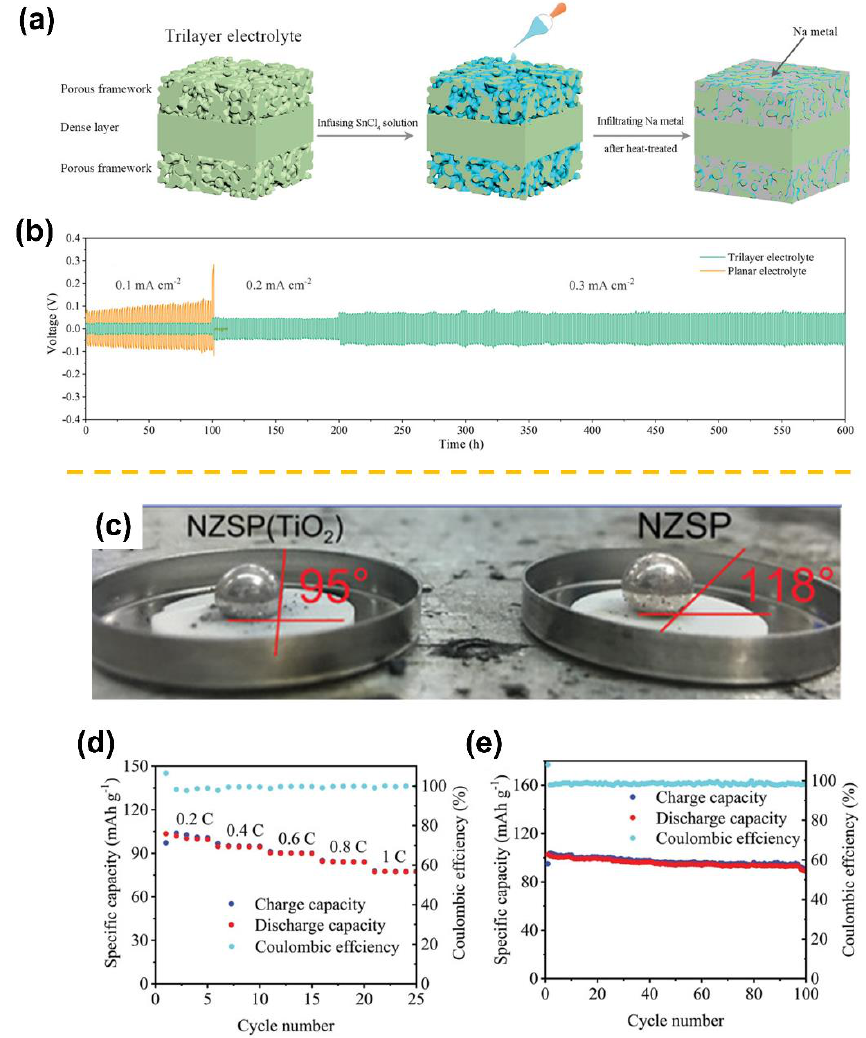
Figure 3. ( a ) Schematic illustration of a trilayer NZSP solid-state electrolyte. ( b ) Voltage profiles of trilayer and planar electrolyte-based symmetric cells. Both electrolytes were surface-modified by SnO 2 (adapted with permission from Wiley). ( c ) Contact-angle measurements for molten Na on NZSP and NZSP (TiO 2 ) surfaces. The Na 3 V 2 (PO 4 ) 3 ||NZSP(TiO 2 )||Na cell: ( d ) rate performance and ( e ) cycle performance at 0.2 C (adapted with permission from Wiley).